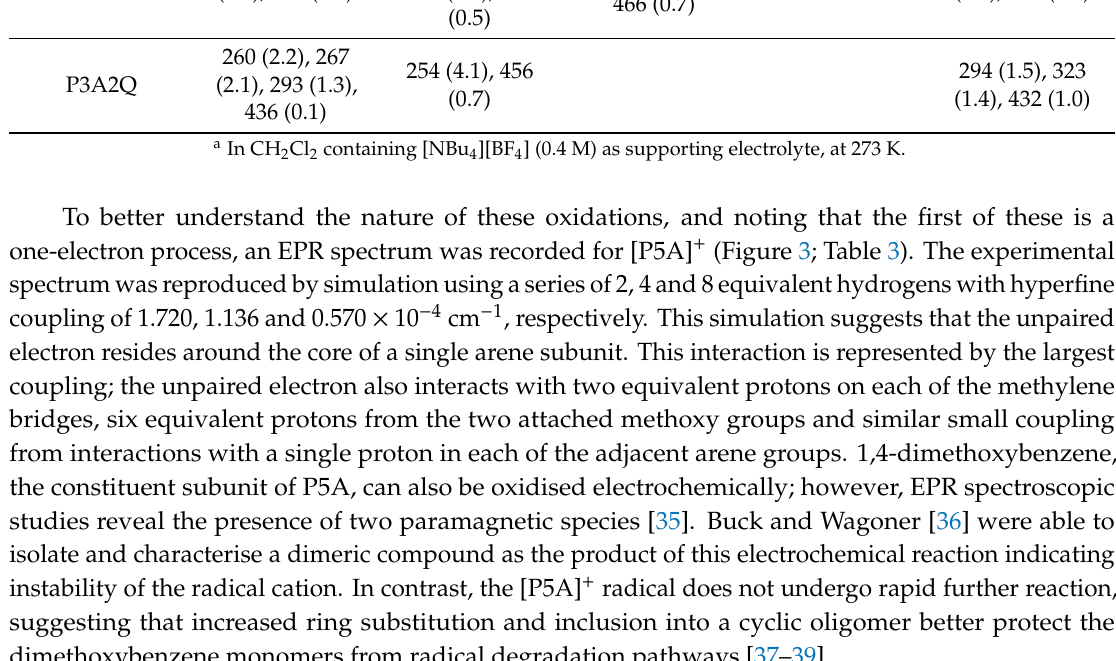
Table 2. UV/vis spectroscopic data. λ abs /nm ( ε x 10 − 3 /mol − 1 dm 3 cm − 1 ) a.